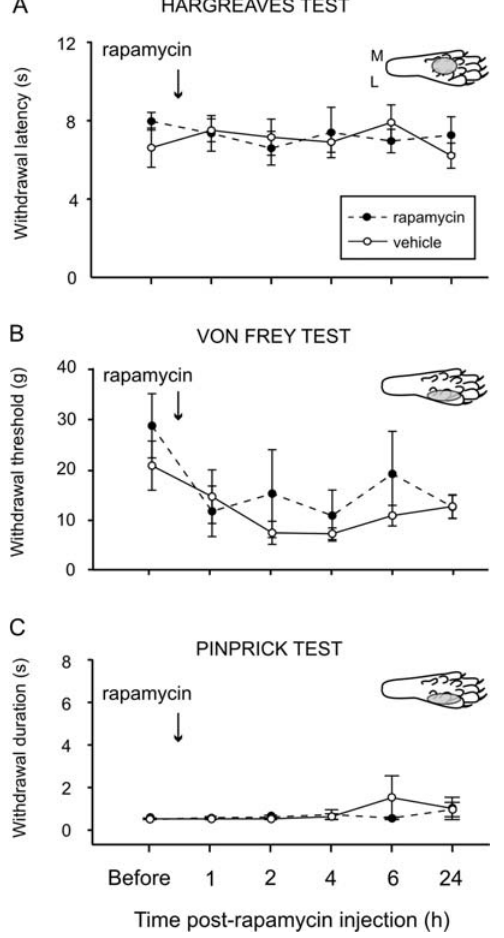
Figure 4. Rapamycin does not alter acute pain. A , B , C , Effects of intraplantar injection of rapamycin (or vehicle) in naı¨ve rats on withdrawal latency to heat using the Hargreaves test ( A ), mechanical withdrawal threshold measured using Von Frey hairs ( B ), and withdrawal response duration after nociceptive mechanical stimulation (pinprick stimulus) of the plantar surface of the paw ( C ). See inset diagrams of the plantar surface of the rat paw for injected areas (gray circles). Mean 6 SEM is illustrated. M, medial; L, lateral.